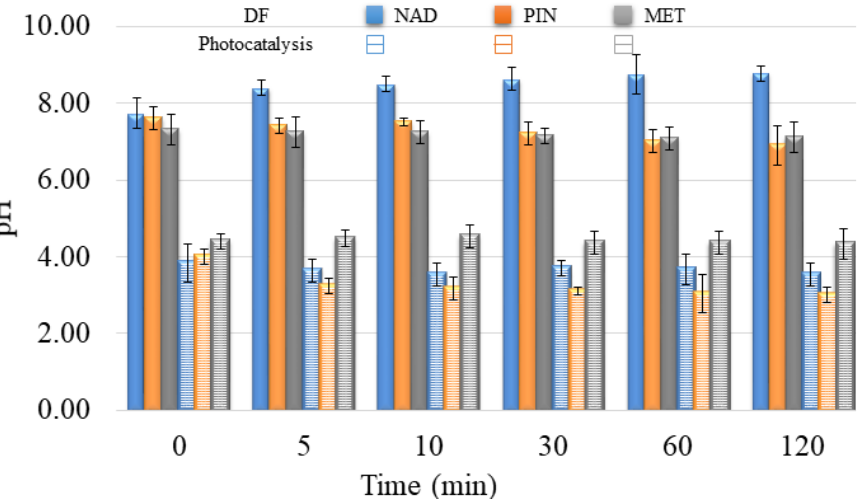
Figure 10. pH value during degradation of selected pharmaceuticals under UV irradiation without V 2 O 5 (DF) and with V 2 O 5 catalyst (Photocatalysis).